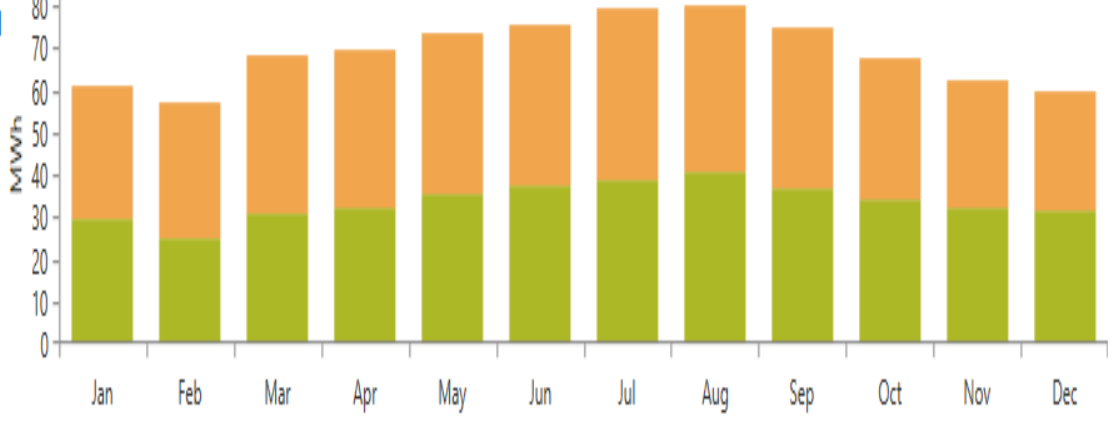
Figure 14. Monthly renewable production for company 3.